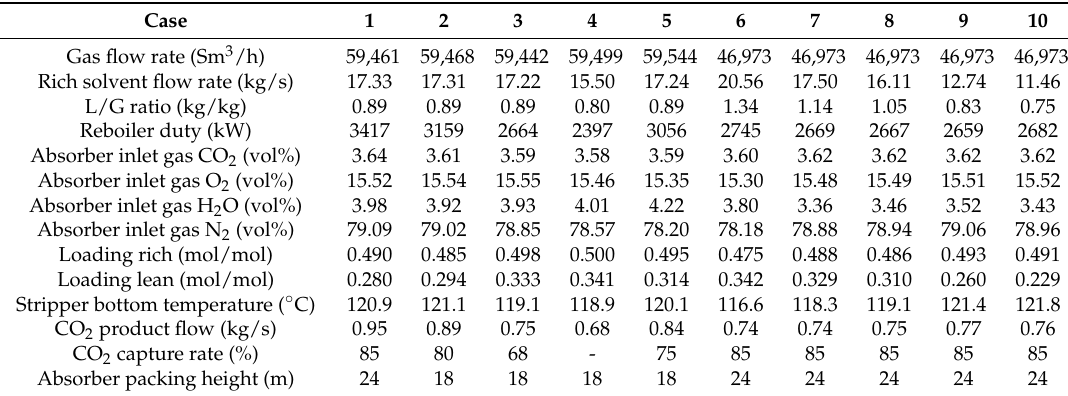
Table 3. A selection of steady-state data cases obtained from the test campaign conducted at TCM plant during autumn 2015. The plant was operated with 30 wt. % aqueous